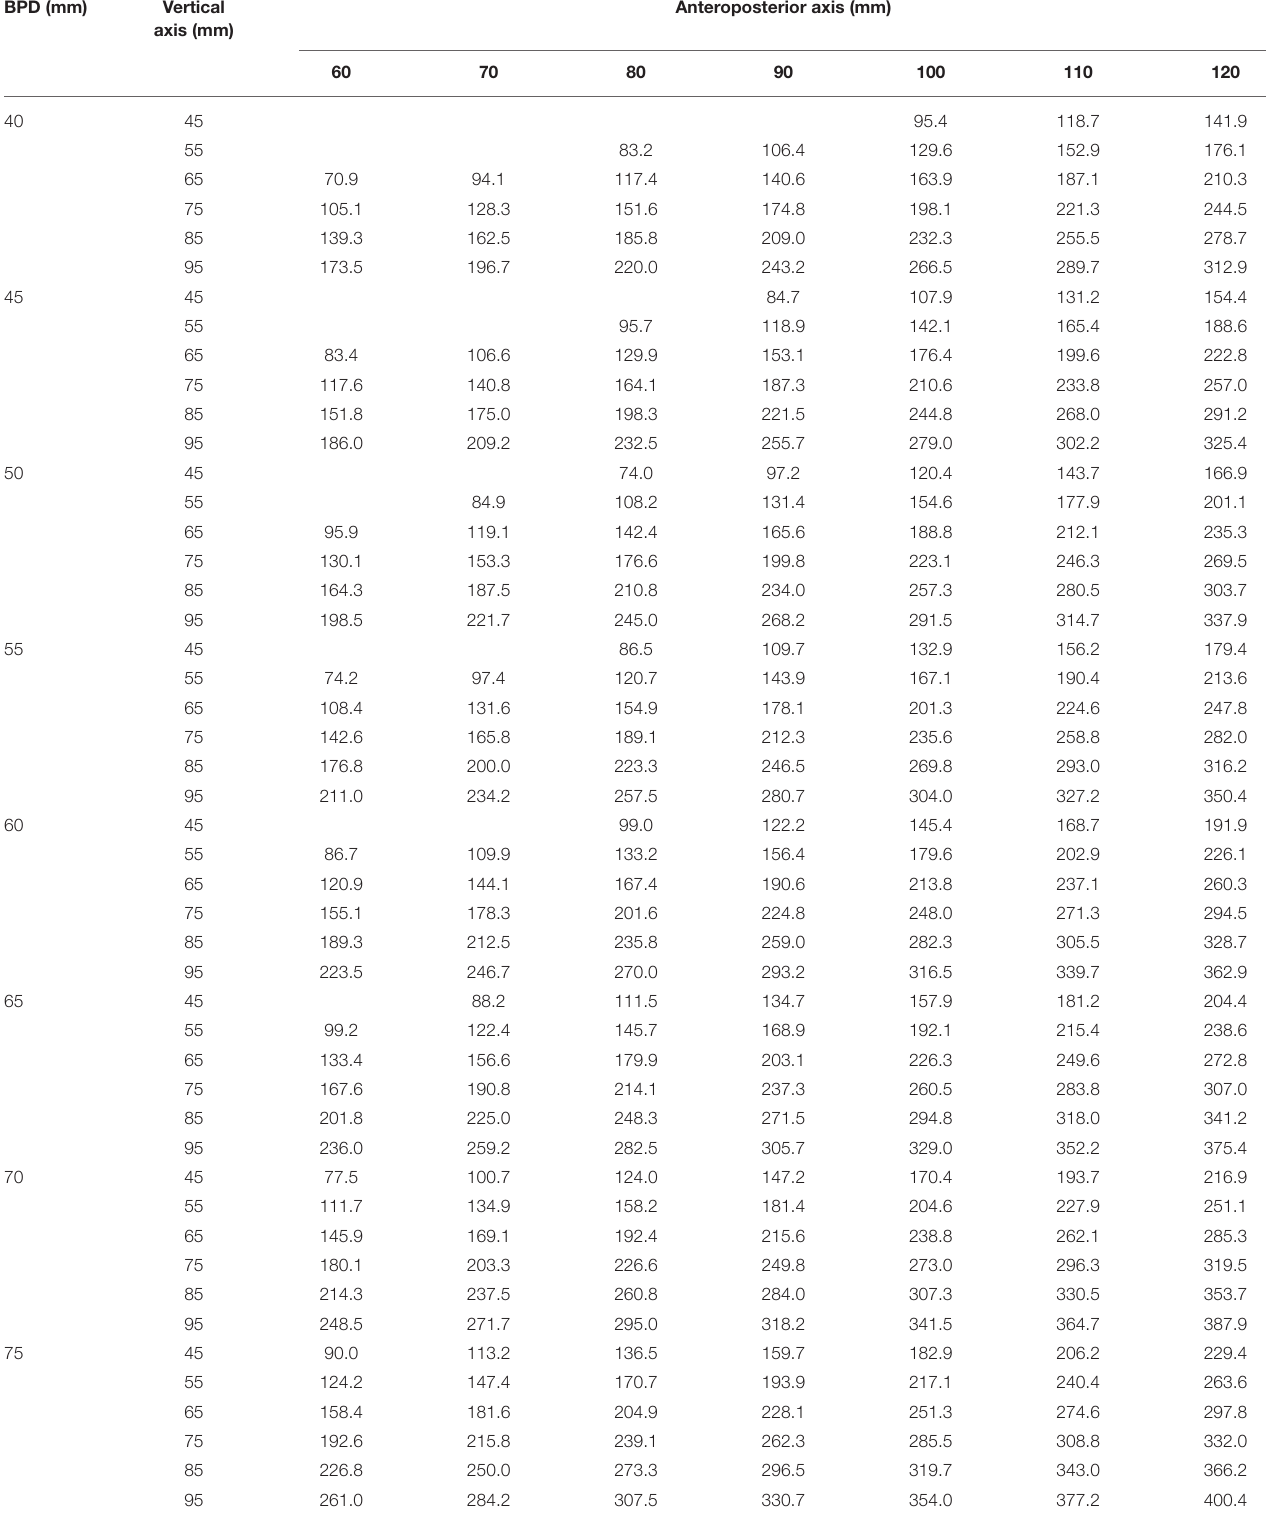
TABLE 8 | Table of predicted US TBV in cm 3 based on BPD (mm), anteroposterior axis (mm), and vertical axis (mm). BPD (mm) Vertical axis